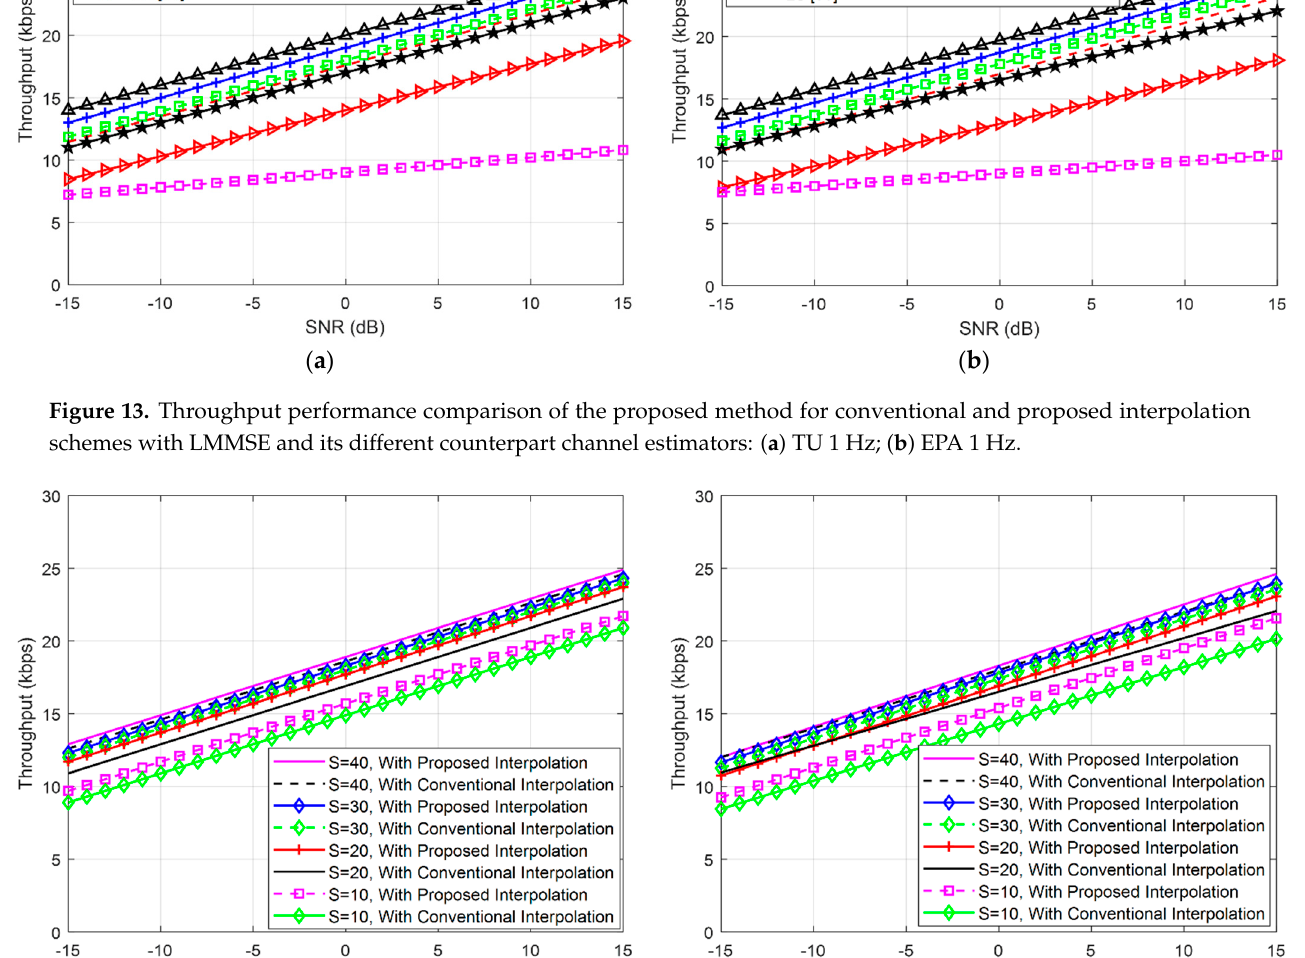
Figure 14. Throughput performance of the proposed technique with conventional and proposed interpolation schemes for different subvector values: ( a ) TU 1 Hz; ( b ) EPA 1 Hz.